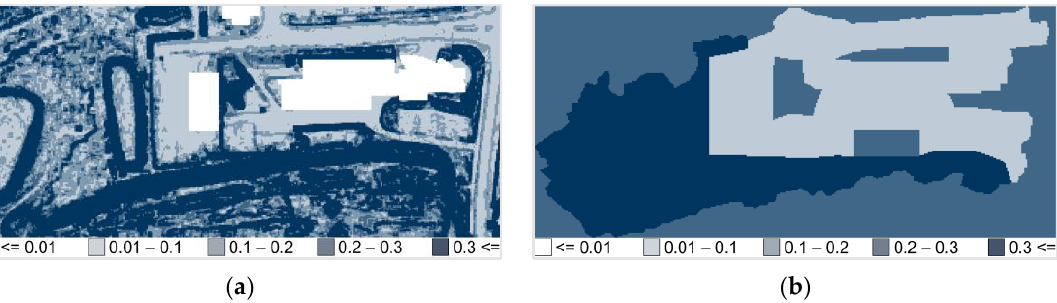
Figure 4. Manning ’ s n values: ( a ) Roughness coefficient automatic generated by QGIS; ( b ) roughness coefficient based on suggested values in the literature.